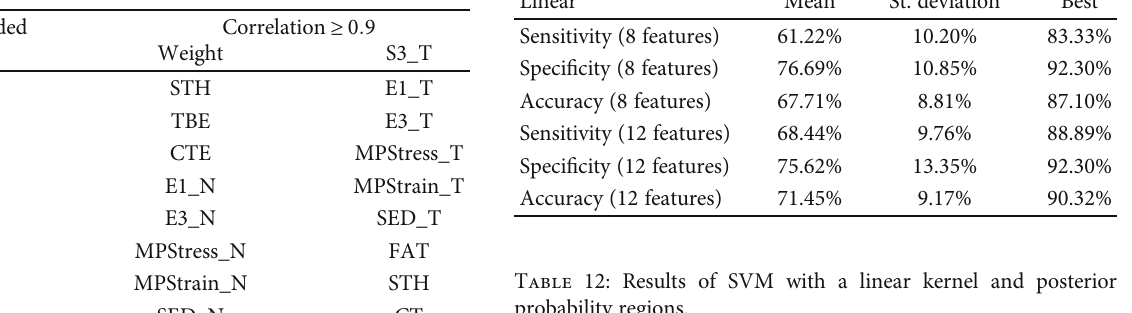
Table 8: Attributes directly included and those included because of their high correlation ( ≥ 0.9).